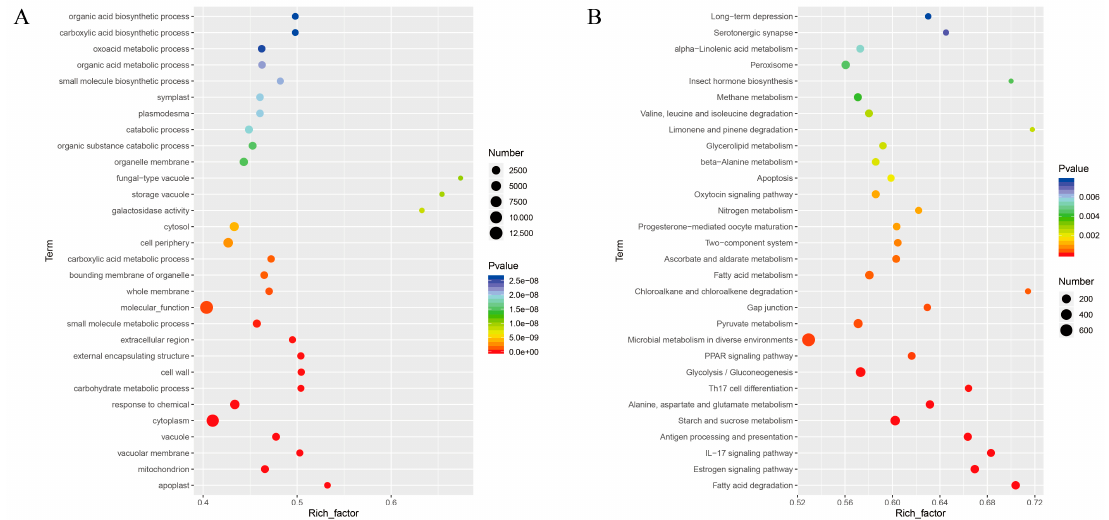
Figure 4. Bubble charts of enrichment for special orthogroups. ( A ) GO enrichment. ( B ) KEGG enrichment.